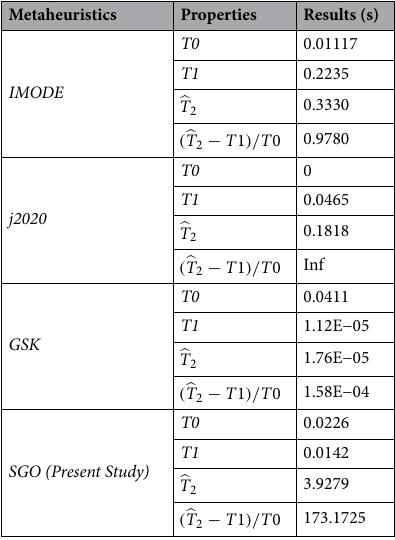
Table 8. Different algorithms’ computational time complexity concerning the CEC 2020 complexity process.